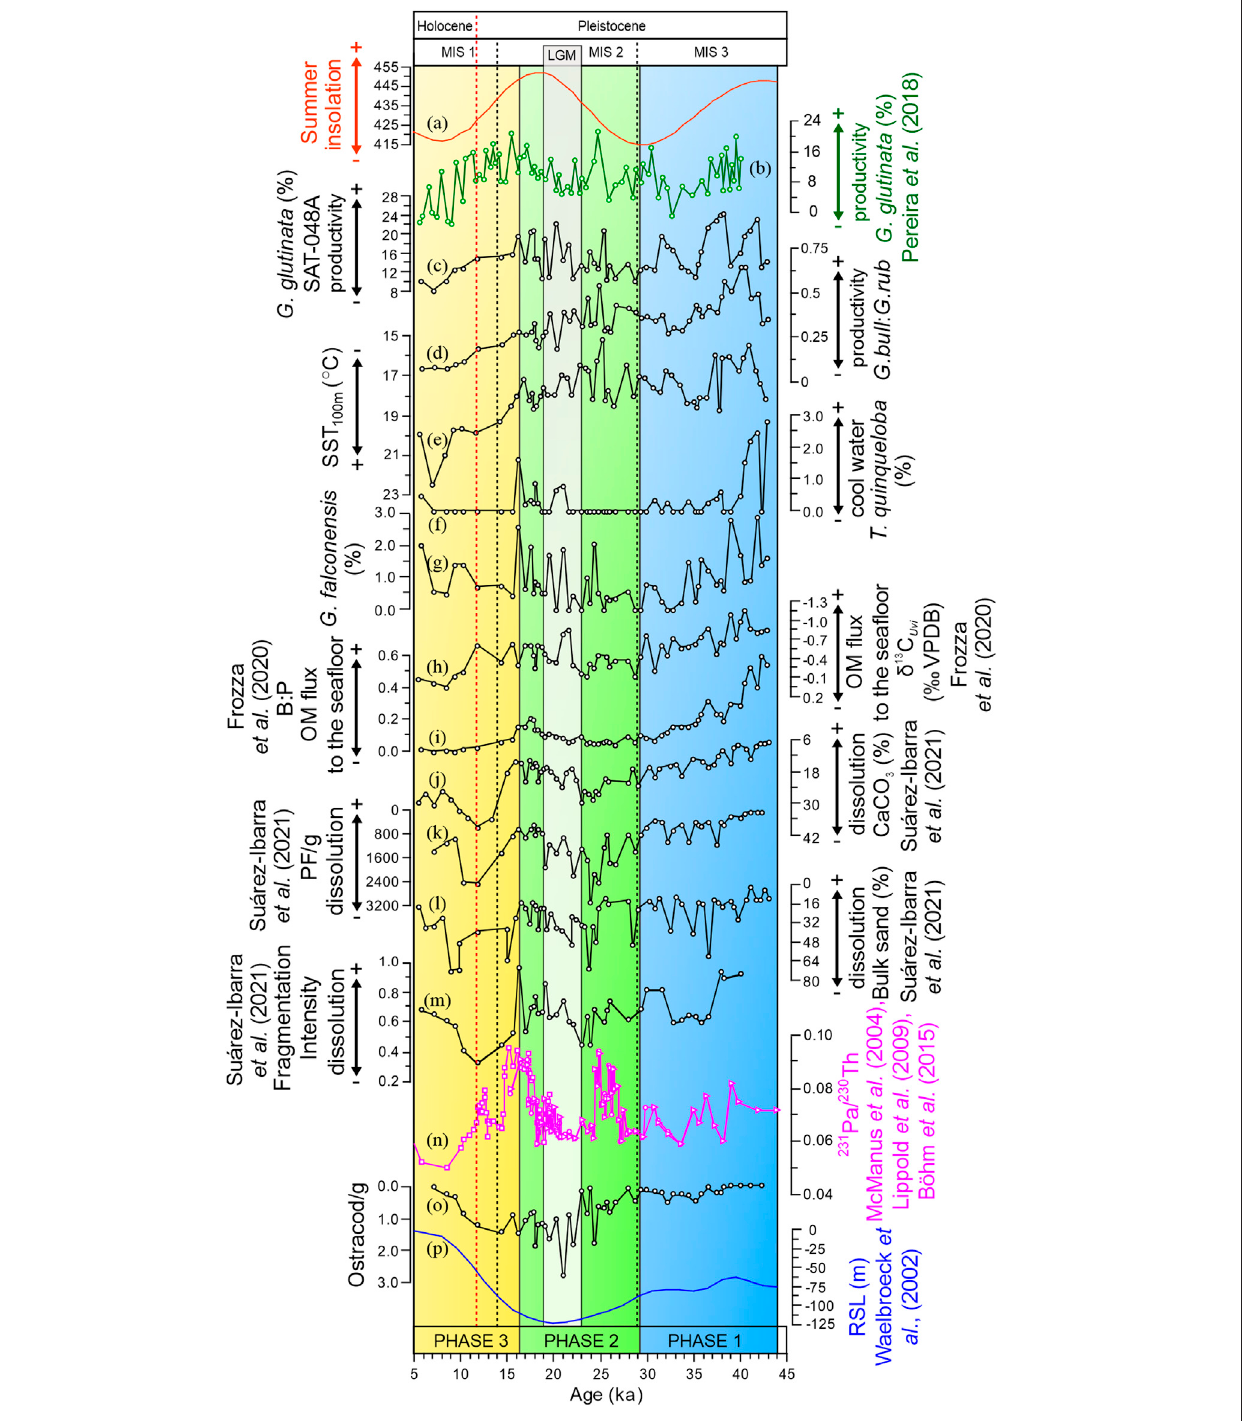
FIGURE 2 | Fluctuations in summer insolation, paleoenvironmental proxies for surface productivity, organic matter (OM) fl ux to the sea fl oor, CaCO 3 dissolution, Atlantic Meridional Overturning Circulation (AMOC) speed, and relative sea level. (A) Austral summer (February) insolation at 31 ° S (Laskar et al., 2004) (B – C) relative abundance of G. glutinata in cores GeoB2107-3 (b; Pereira et al., 2018) and SAT-048A (c; this study); (D) G. bulloides / G. ruber ratio ( G.bull : G.rub ); (E) SST 100m ( ° C) (F – G) relative abundance of T. quinqueloba (f) and G. falconensis (g); (H) δ 13 C Uvi ( ‰ ); (I) Benthic/Planktonic Foraminifera ratio (B:P) (J) CaCO 3 content of the sediment (K) number of planktonic Foraminifera tests per gram of sediment (PF/g) (L) sand bulk content (%) (M) fragmentation intensity (N) 231 Pa/ 230 Th values from McManus et al. (2004; squares), Lippold et al. (2009; circles), and Böhm et al. (2015; triangles) (O) Ostracods per gram of sediment (valves/g) (P) relative sea level (RSL; Waelbroeck et al., 2002). Note the inverted y -axes in (f), (g), and (i – k) to aid visualization. Proxies printed in black belong to sediment core SAT-048A. The three phases indicated in the plot are based on a principal component analysis of all productivity values, as shown in Figure 3 .